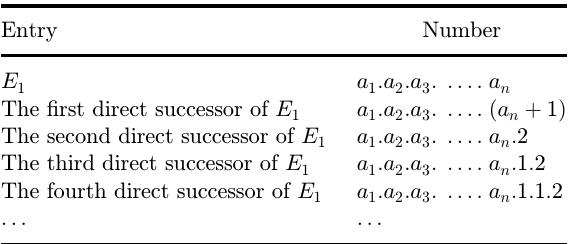
Table 1. Number relationships between each entry and its direct successors in the tree